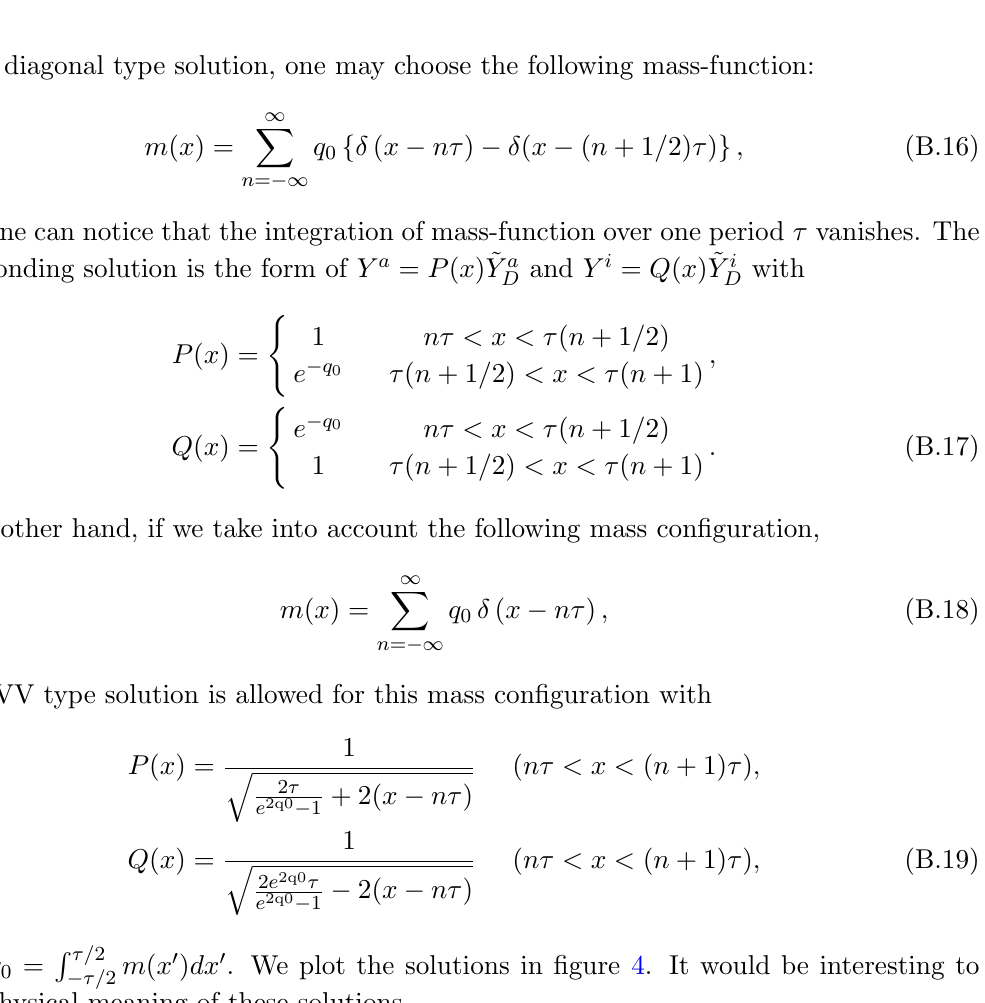
Figure 3 . GRVV Types with mass-function m ( x ) =